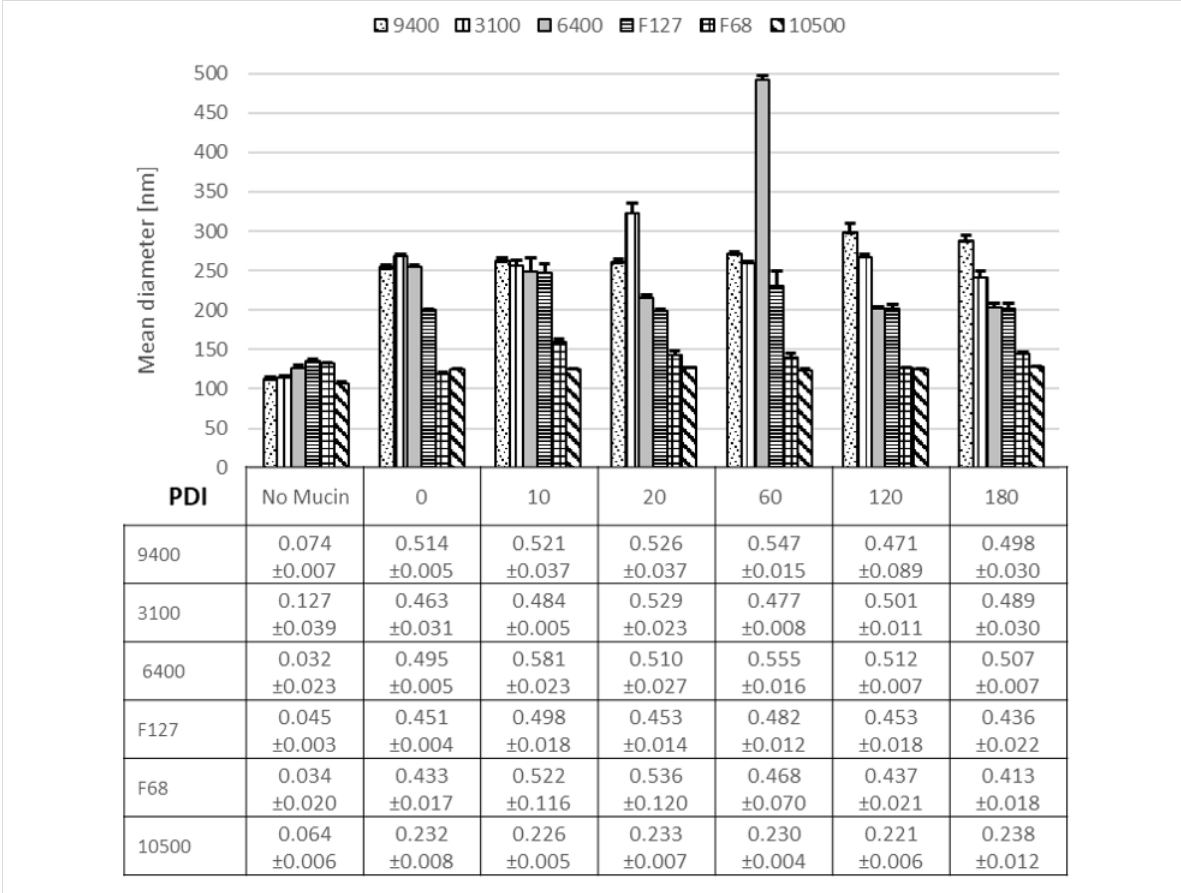
Figure 11: Size and size distribution of nanoparticles stabilized with different types of Pluronic before and after their distribution and interaction with mucin.